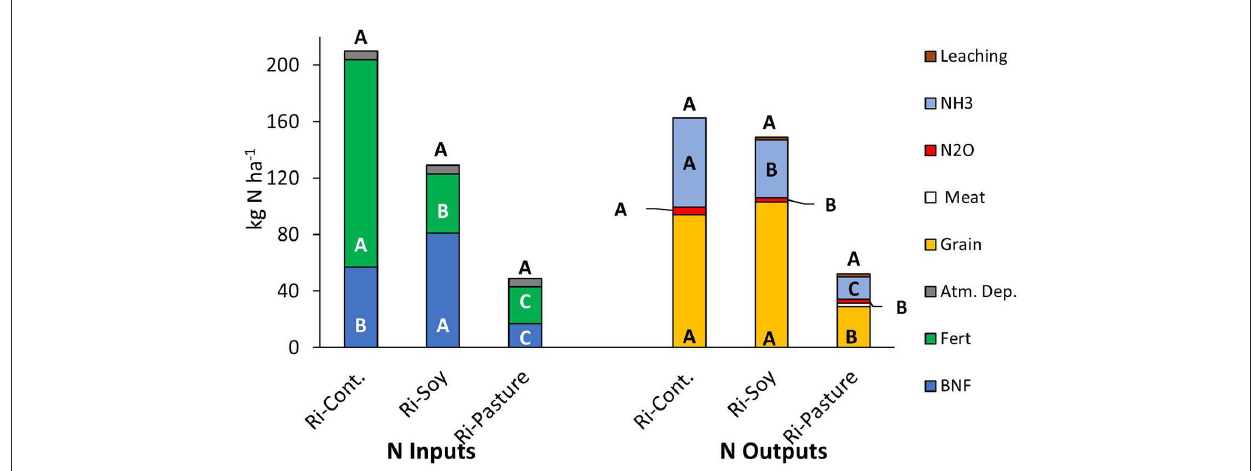
FIGURE6 Composition of N inputs and outputs and average N amounts for rice-pasture, rice-soybean and continuous rice in 2019–2020 and 2020–2021 growing seasons. Letters next to bars indicate differences (Fisher 5%) between the rotations for each indicated component.